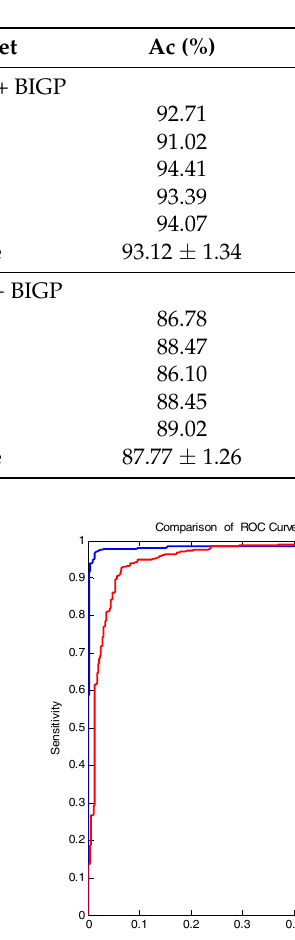
Table 6. 5-fold cross validation results performed by SVM and RVM classifier on an ion channel dataset.